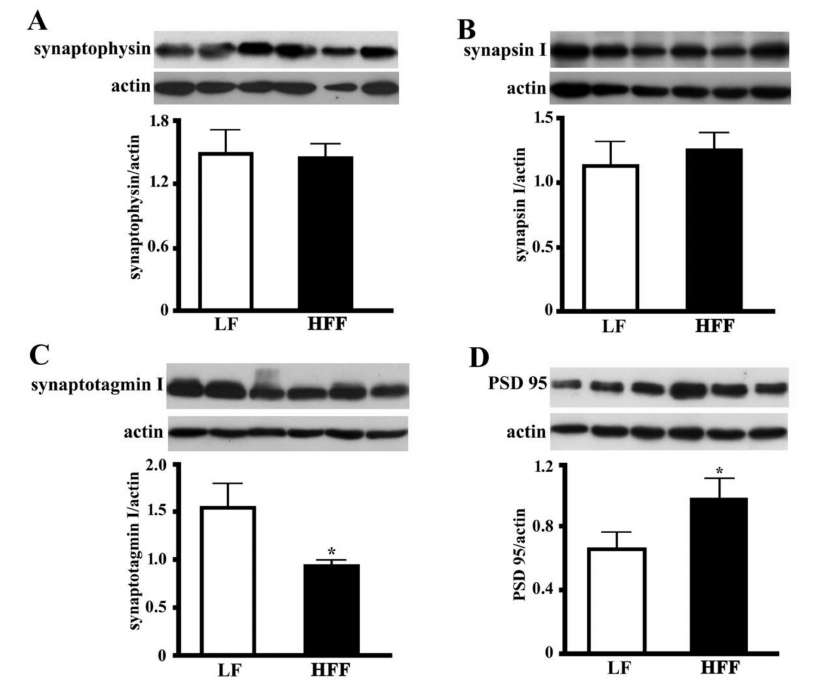
Figure 10. Protein content (with representative western blot) of presynaptic proteins synaptophysin ( A ), synapsin I ( B ) and synaptotagmin I ( C ), and postsynaptic protein PSD-95 ( D ) in the hippocampus from middle-aged rats fed low fat (LF) or high fat-high fructose (HFF) diets for four weeks. Values are the means ± SEM of eight rats. * p < 0.05 compared to low-fat diet (two-tailed Student’s t-test).